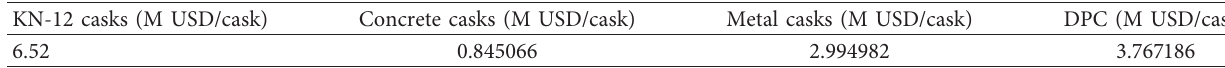
Table 10: Normalized cask cost options from year 2017 forward to 2020.